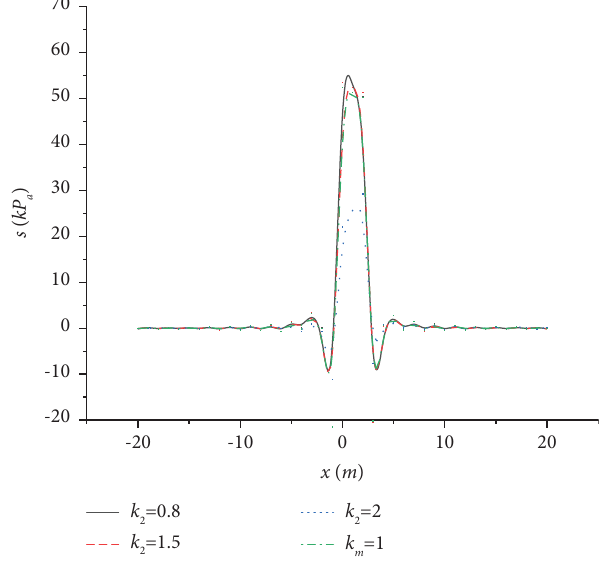
Figure 9: Contact stress curves in x- direction due to E